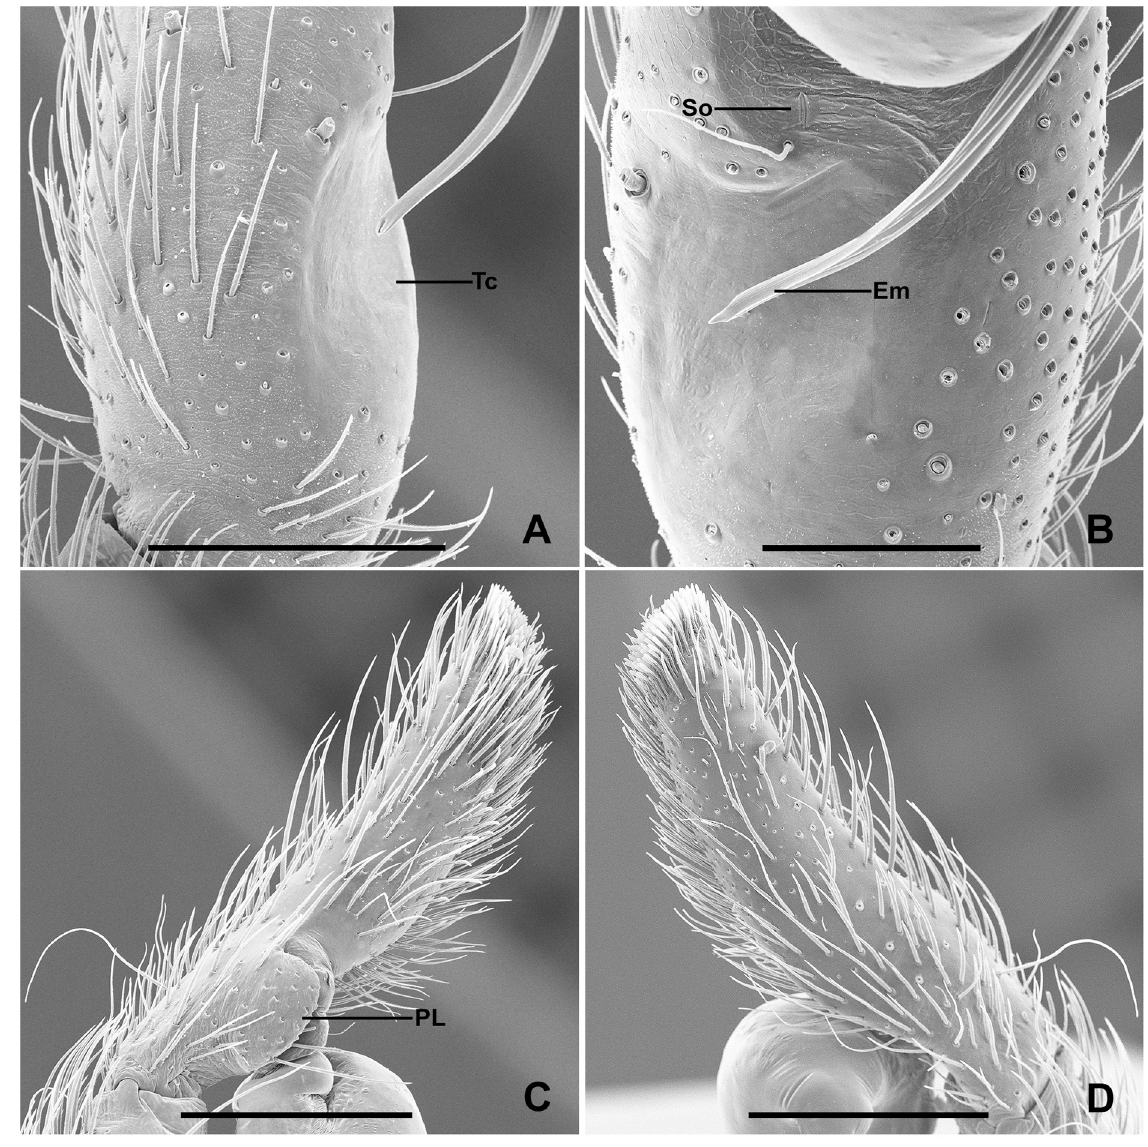
Fig. 3. SEM micrographs of the male palp of Ammonius pupulus Thorell, 1899 (RMCA 227221). A–B . Tibial concavity. A . Prolateral view. B . Retrolateral view. C–D . Cymbium. C . Prolateral view. D . Retrolateral view. Abbreviations: Em = embolus; PL = prolateral lobe; So = slit organ; Tc = tibial concavity. Scale bars: A = 400 µm; B = 200 µm; C–D = 400